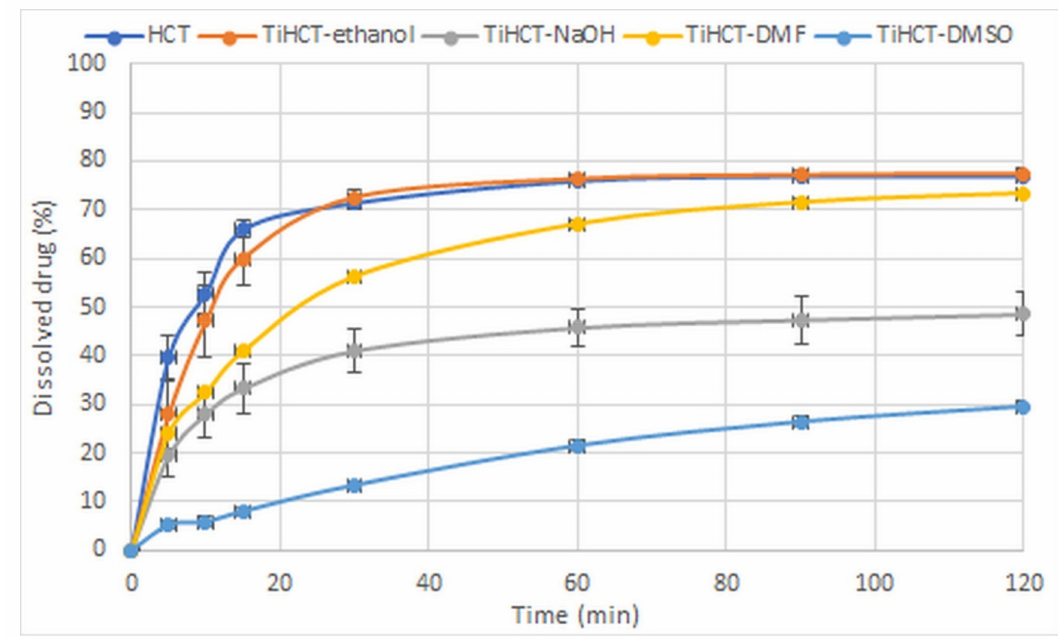
Figure 11. Dissolution study of TiHCT composites in gastric juice (non-sink